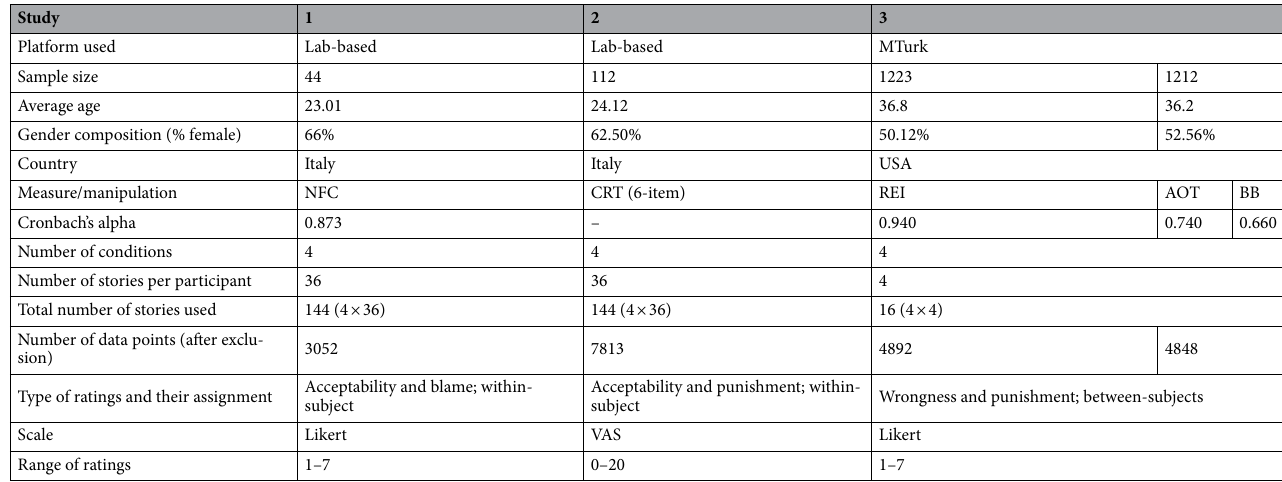
Table 1. Details about experimental designs included in Studies 1–3 and demographic details for participants. Questions and scale labels used for different questions: Wrongness (How wrong was [the agent]’s behavior?; 1: not at all , 7: very much ), Punishment (How much should [the agent]’s be punished?; 1 (or 0): none at all , 7 (or 20): a lot ), Acceptability (“How morally acceptable was [the agent]’s behavior?”; 1 (or 0): not at all acceptable